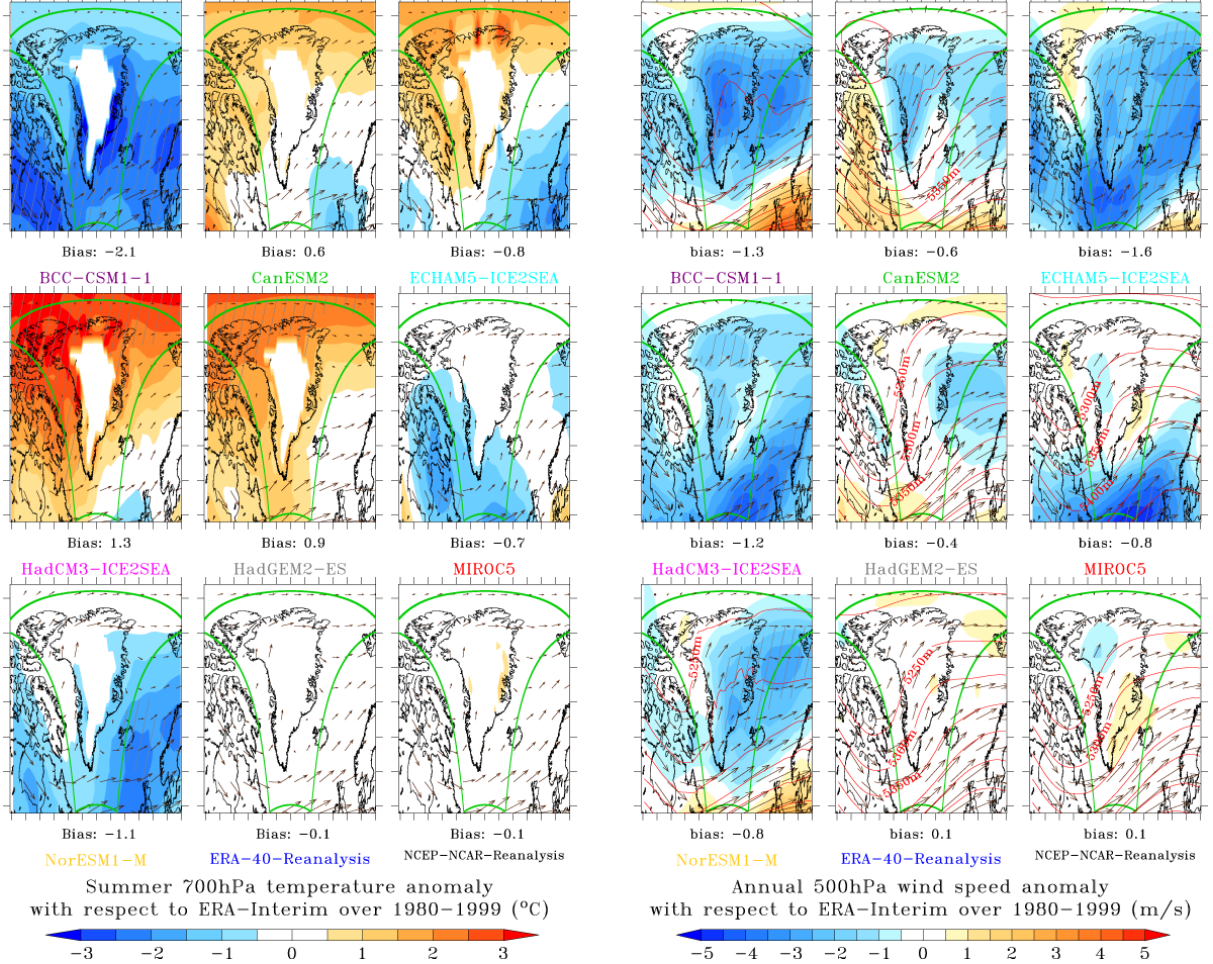
Fig. 2. (Left) Mean anomalies of the JJA 700hPa temperature simulated by the different GCMs used in this study with respect to ERA- Interim over 1980–1999. The JJA mean wind vectors (not anomalies) at 700hPa are also plotted and the mean temperature bias is listed in normalised value. The boundaries of the MAR integration domain are plotted in green and the areas where the anomalies are two times above the 1980–1999 standard deviation of ERA-Interim are hatched in dark grey. Finally, it must be noted that the data sets are shown here by using their native Lat and Long projections. Right panel same as left but for the annual mean wind speed at 500hPa. The annual mean wind vectors at 500hPa and isohypses of the geopotential height at 500hPa are also plotted in black and red,